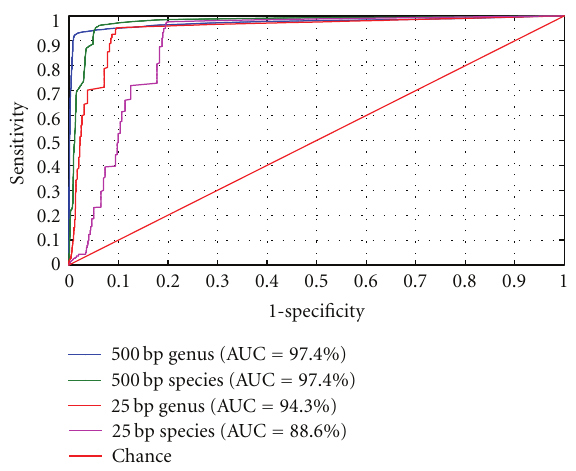
Figure 3: Comparison of ROC curves using the likelihood-based NBC scores. The AUC metric shows that the detector performs best on 500 bp reads (and not that much lower for 25 bp) for both the species and genus levels for the 100 reads each from the 635 known and 102 unknown training genomes.